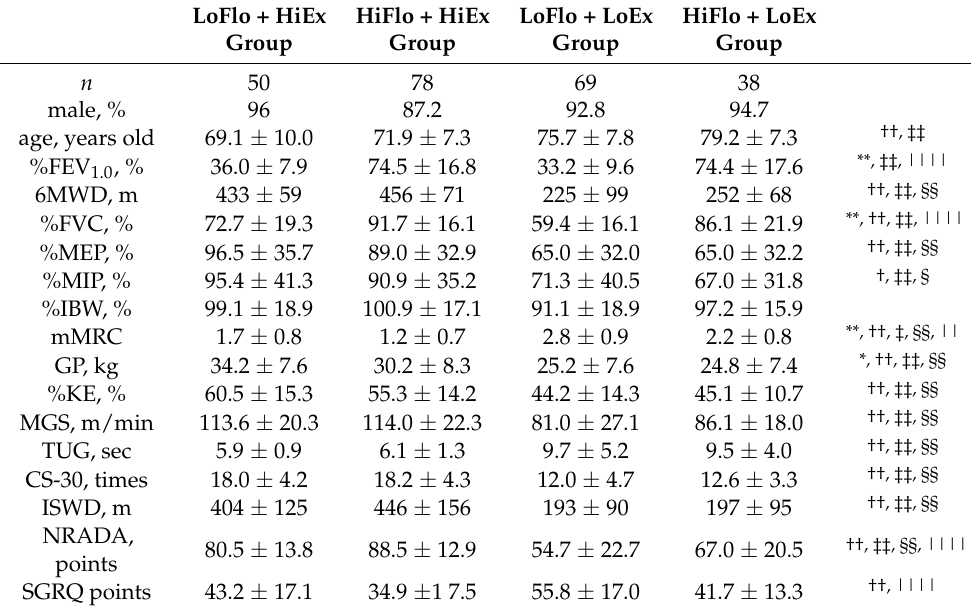
Table 1. Comparison of the characteristics of the LoFlo + HiEx, HiFlo + HiEx, LoFlo + LoEx, and HiFlo + LoEx